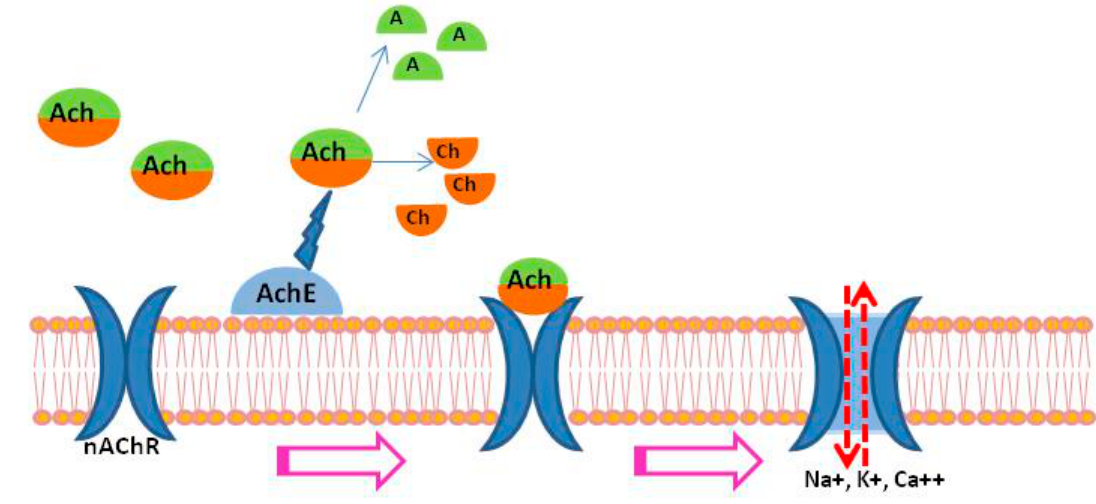
Figure 1. Predicted cholinergic signaling in schistosomes.